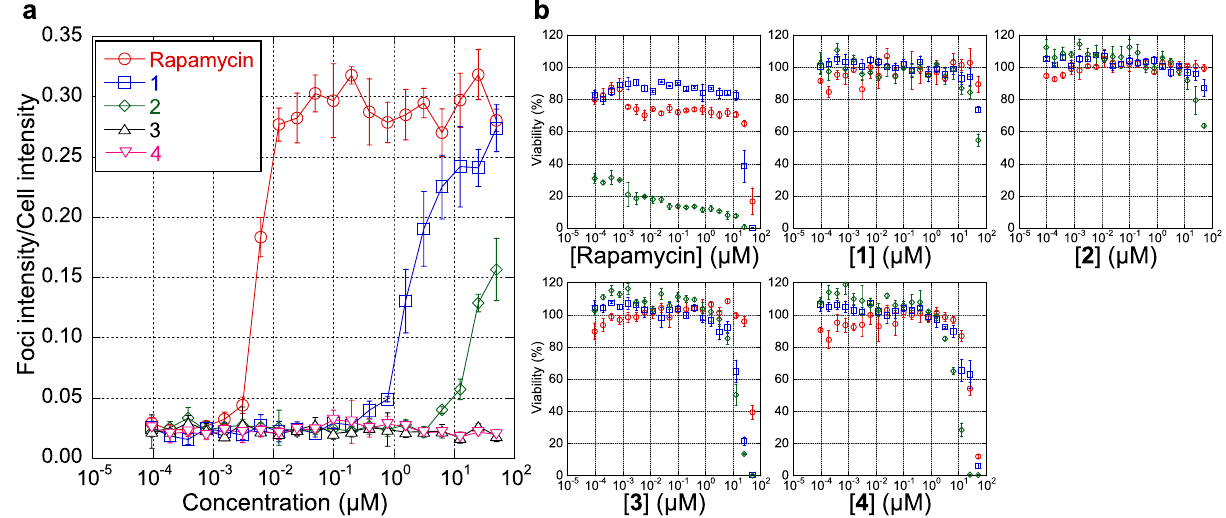
Figure 4. Biological activities. ( a ) Binding activities of rapamycin and its derivatives to FKBP and mTOR. ( b ) cytostatic activities of rapamycin and its derivatives to SKOV-3 (red), MESO-1 (blue) and Jurkat (green) cells. Each plot with error bars indicates average ± s.d. calculated from three independent biological